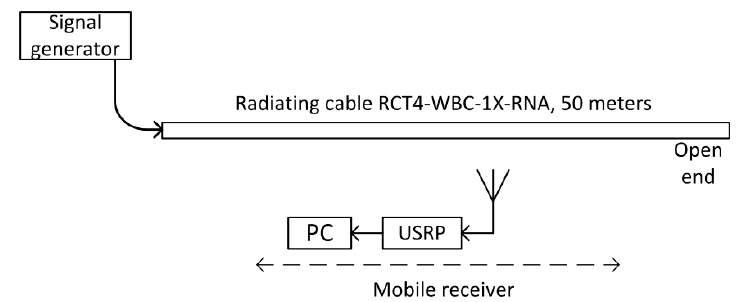
Figure 2. Measuring stand for estimation of position based on the reflection of the test signal from the open end of radiating cable.